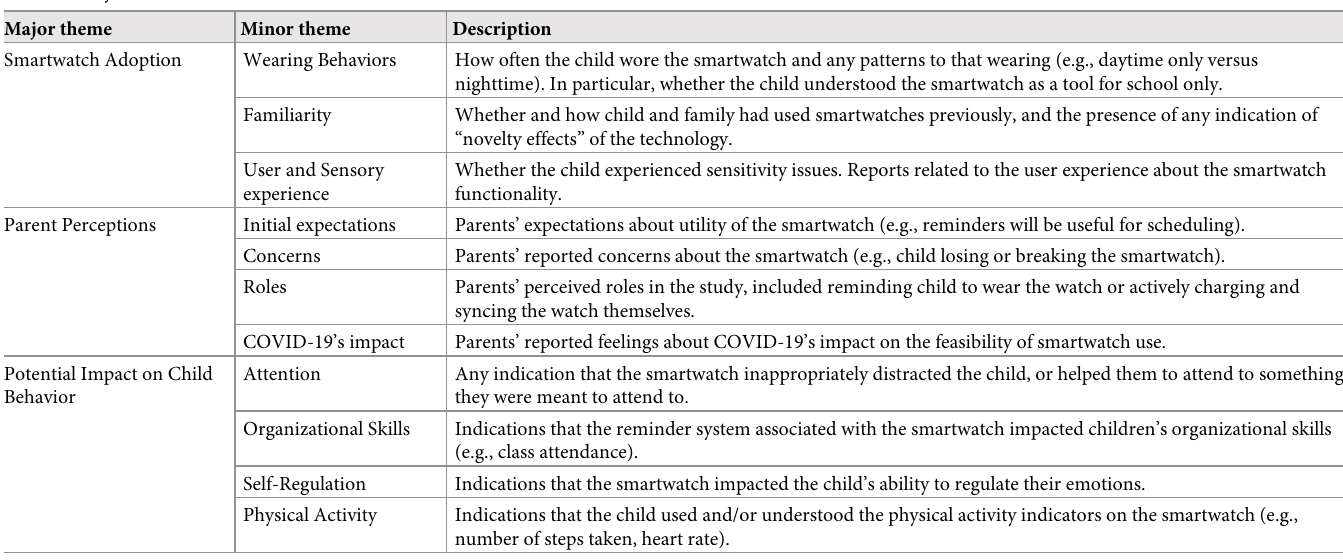
Table 2. Major and minor